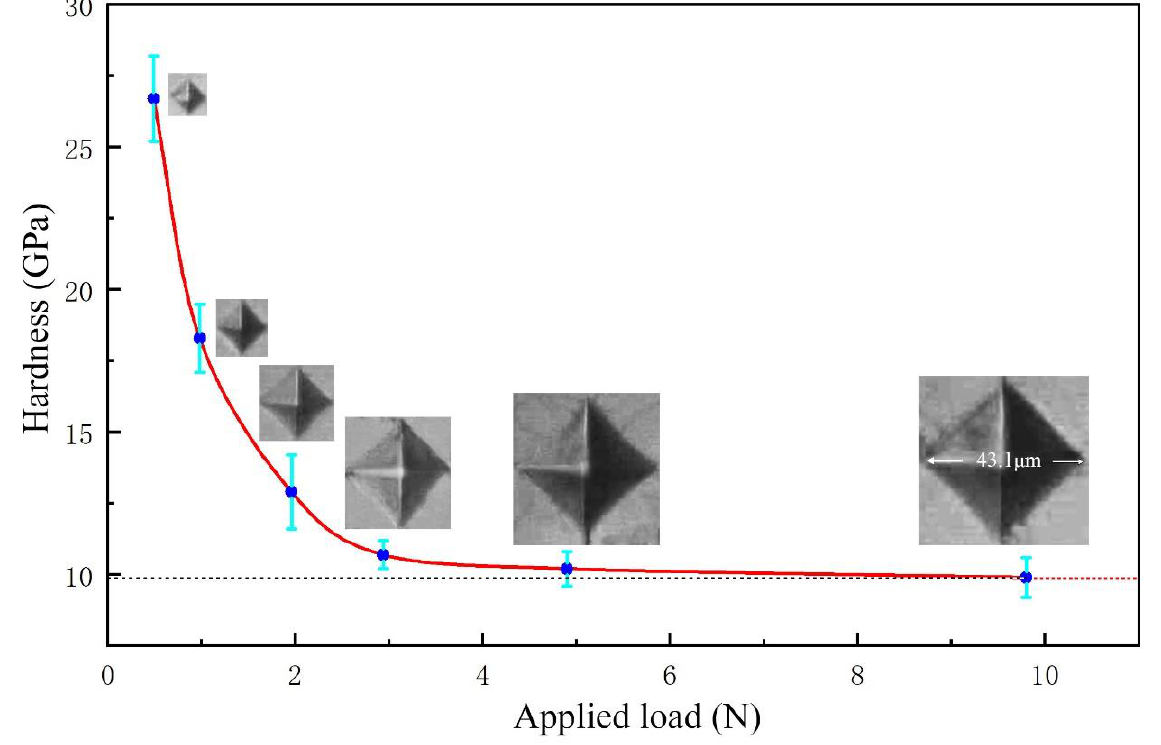
Figure 4. Vickers hardness for Mn 3 N 2 , with the applied load ranging from 0.49 N (low load) to 9.8 N (high load). Typical optical images of the indentation are shown in the inset.